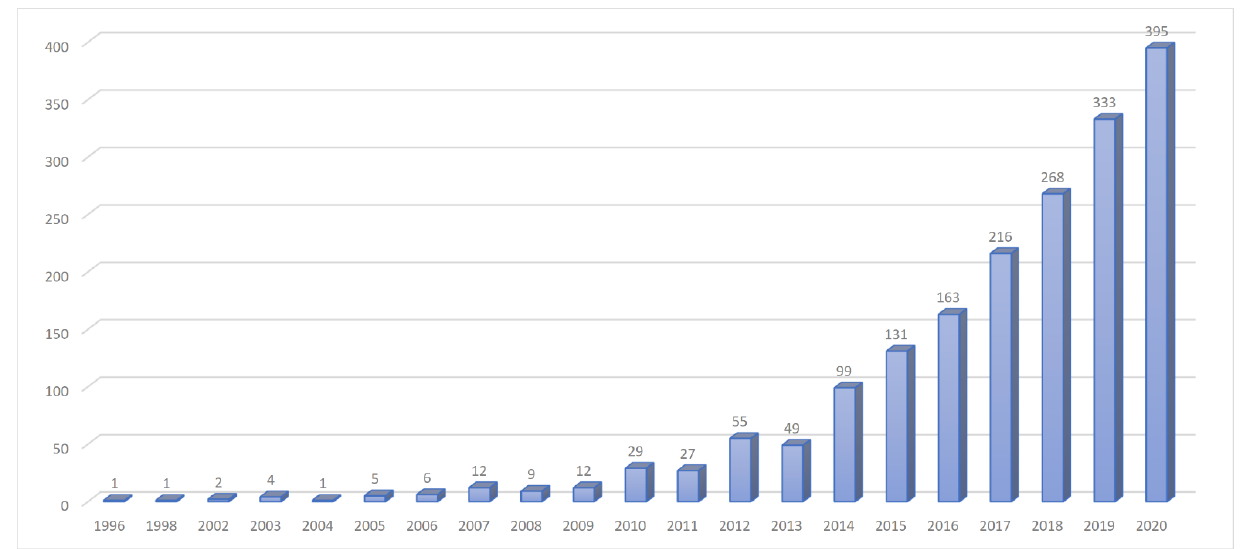
Figure 2. Increasing number of scientific papers on oligometastatic disease per year from 1996 to 2020. Results correspond to the search term “oligometastatic” in the National Library of Medicine on 4 April 2021 (https://pub- med.ncbi.nlm.nih.gov).